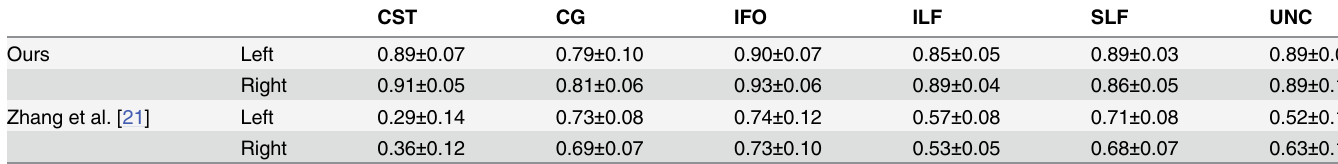
Table 3. Comparison of kappa statistics with a ROI-based method [21].